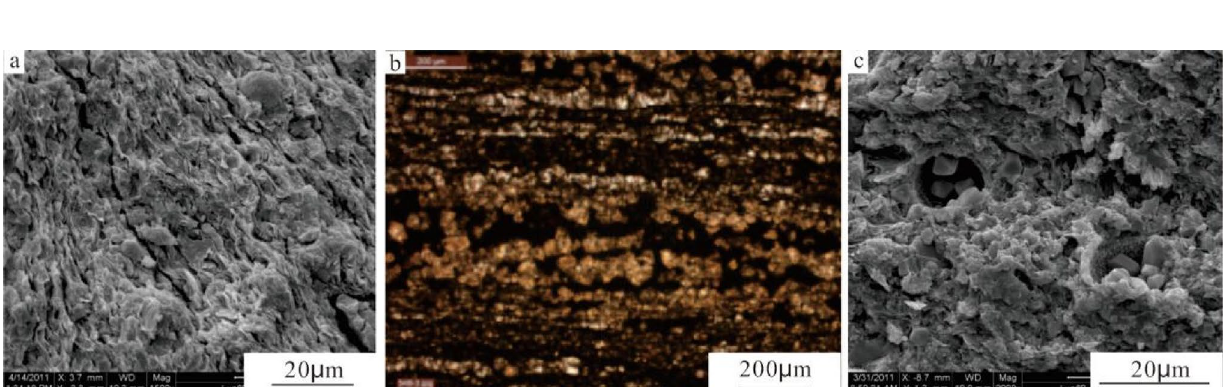
Fig. 6 Pore type reservoir space in shale of the Shahejie Forma- tion. a Well Luo 69, 3039.60 m, with developed flaky micropores and strawberry pyrite, b Well Luo 69, 3055.60 m, Asphalt is found